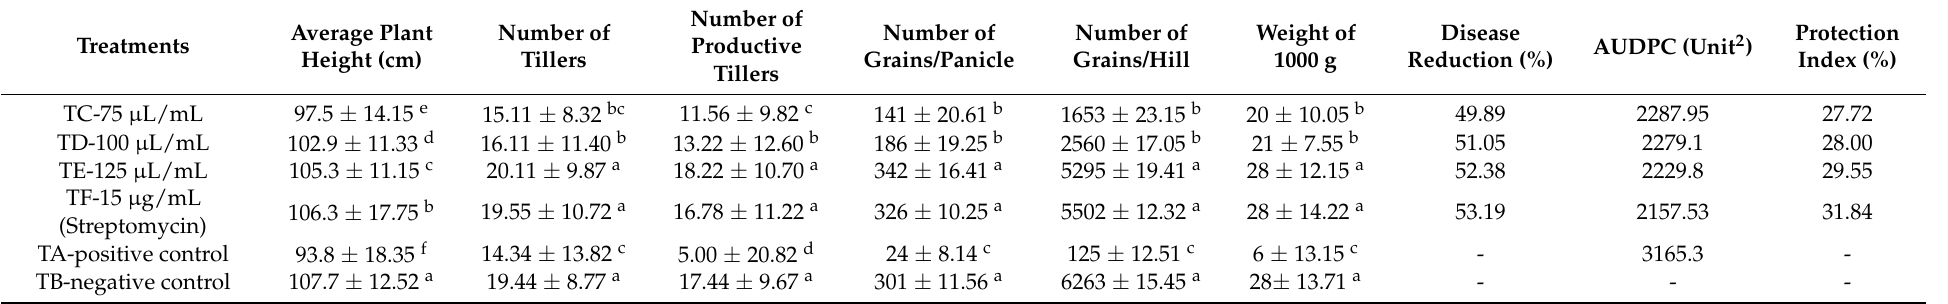
Table 2. Effect of developed nanobactericides application on the disease reduction (DR), protection index (PI), AUDPC value, and yield parameters for rice plant after being challenged with Xanthomonas oryzae pv. oryzae under a glasshouse